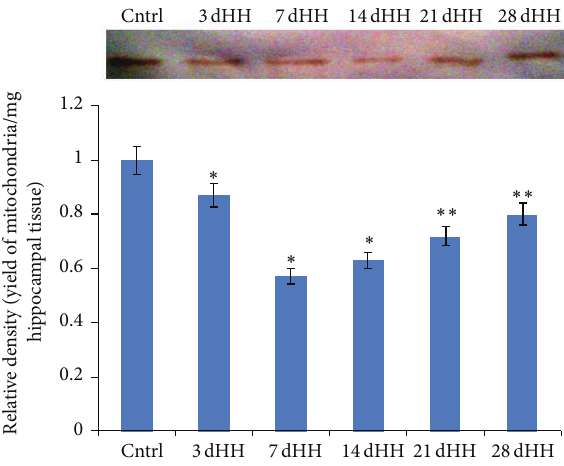
Figure 1: Photomicrograph of immunoblot and densitometric analysis of MTCO1 (mitochondrial marker) protein depict yield of mitochondria decreases in HH exposure. Result showed mean ± SEM for 𝑛 = 6 in each group. “ ∗ ” and “ ∗∗ ” denote 𝑝 < 0.05 and 𝑝 < 0.01 , respectively, compared to